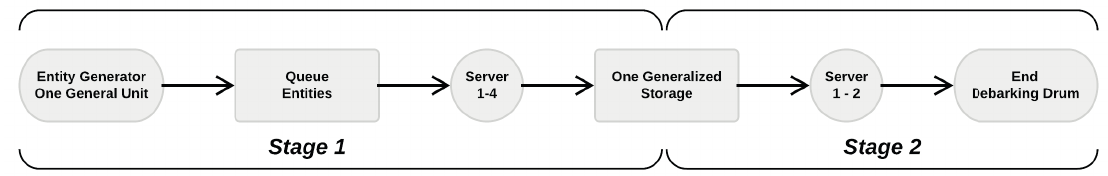
Figure 10. A general model 2 system layout of log-yard logistics at a pulp